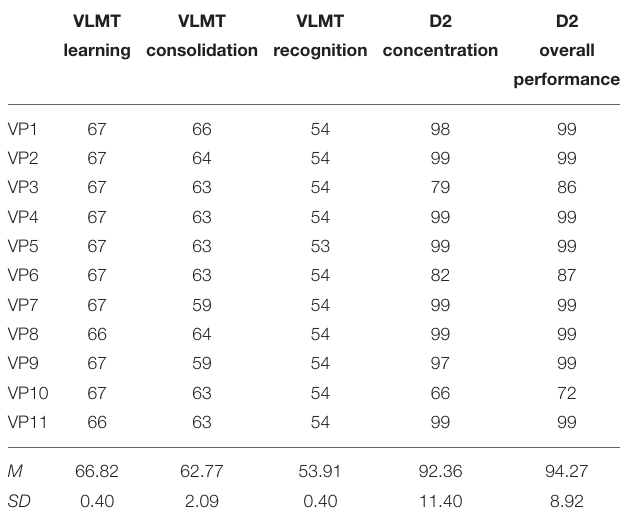
TABLE 3 | Test values for the VLMT ( T -values) and the d2-test (percentile ranks) subscales.